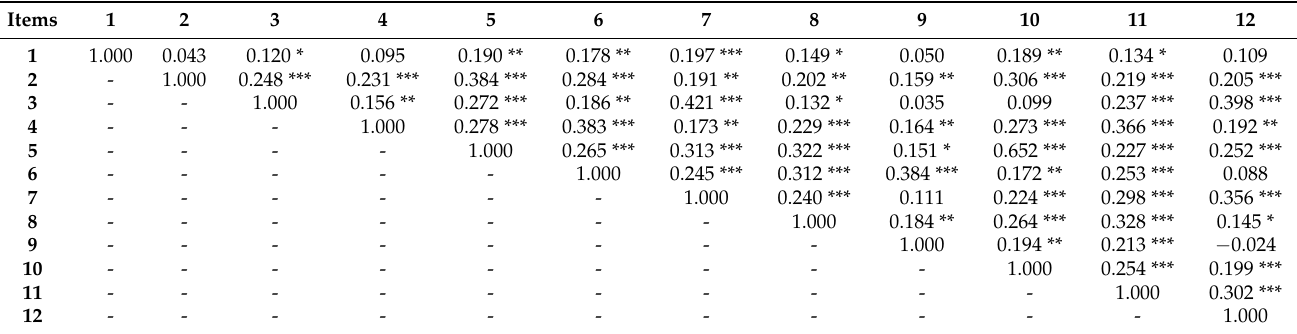
Table 6. Correlation between OHVS item scores.